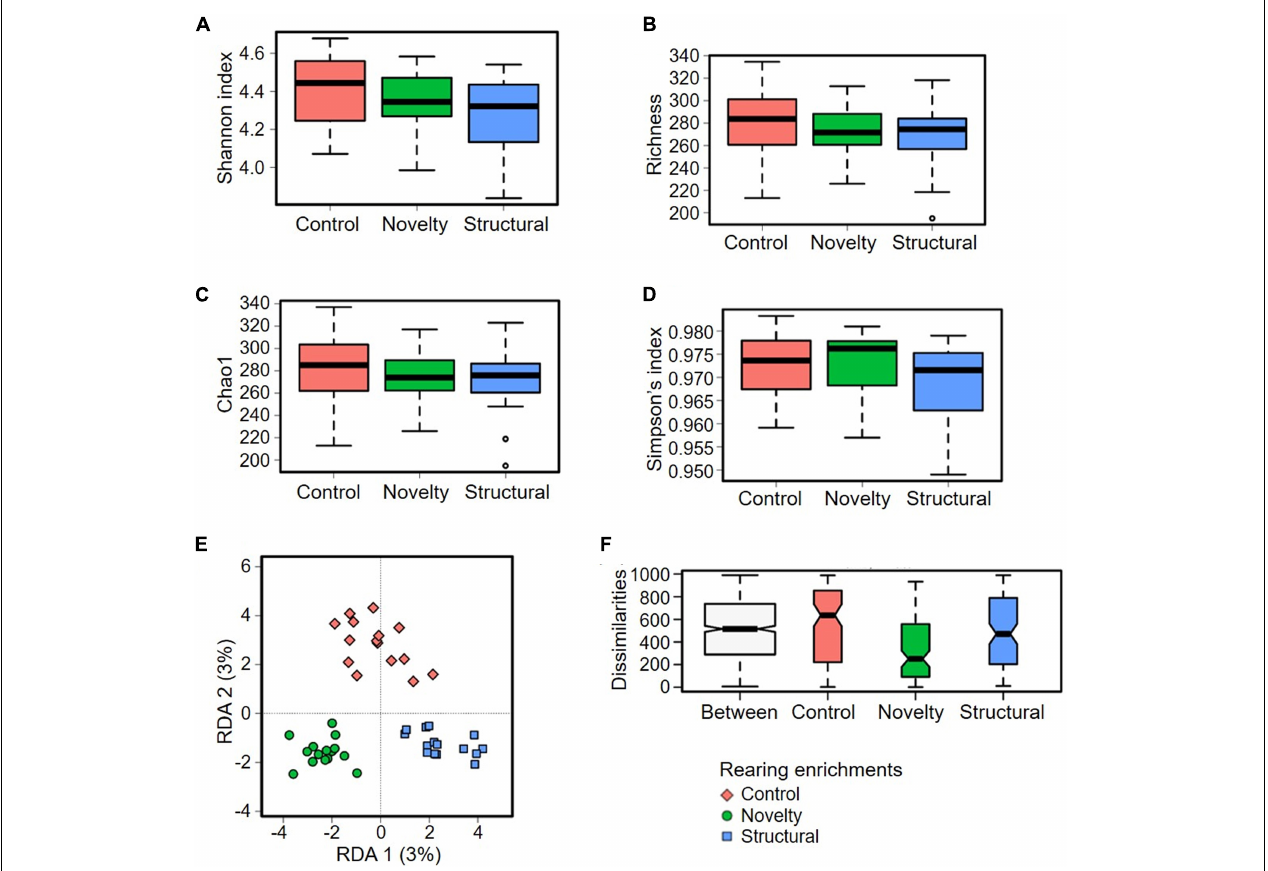
FIGURE 3 | Microbial diversity of cecal microbiota of pullets at 15 weeks of age from different rearing enrichments (control, novelty, structural) at ASV level. Alpha diversity: (A) Shannon index, P = 0.17; (B) Richness, P = 0.51; (C) Chao1, P = 0.54; (D) Simpson’s index, P = 0.34; and Beta diversity: (E) Redundancy analysis (RDA), P = 0.002; (F) ANOSIM (Bray-Curtis), P =